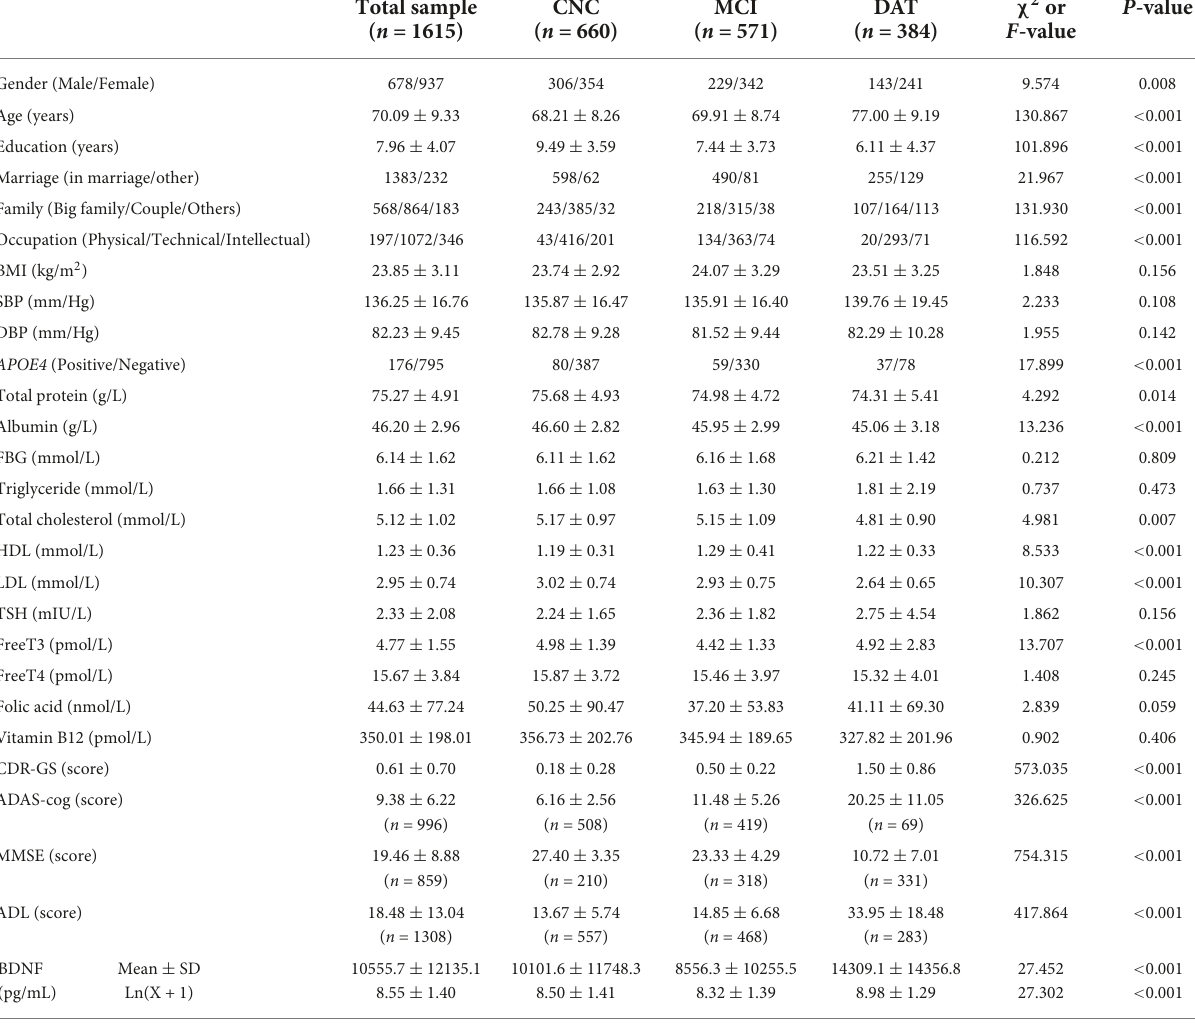
TABLE 2 Demographic, clinical and laboratory data and cognitive scores of the three groups.